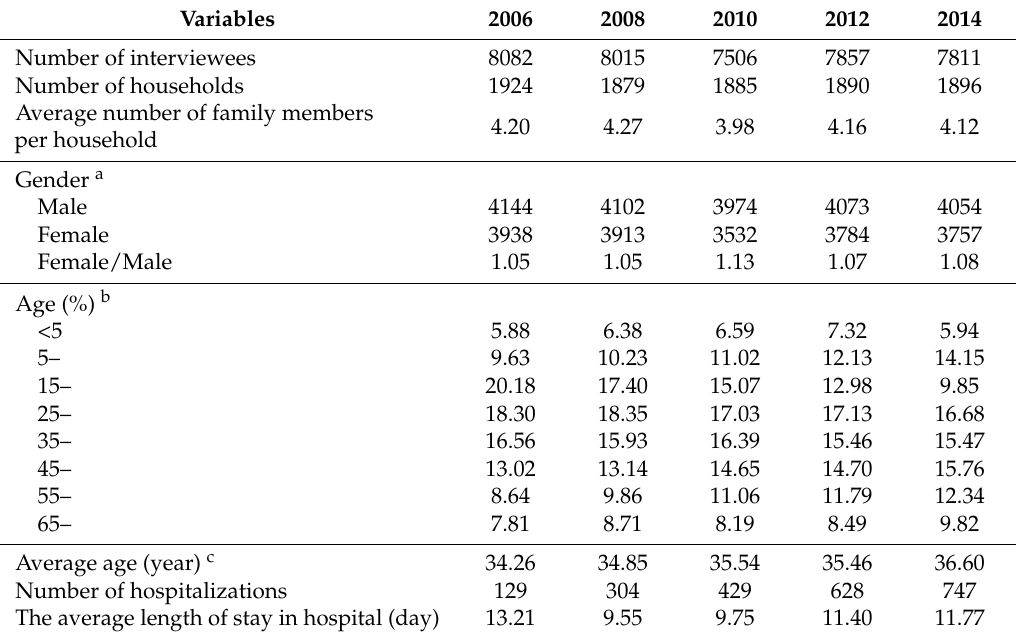
Table 2. Demographic characteristics of rural residents in Jiangxi